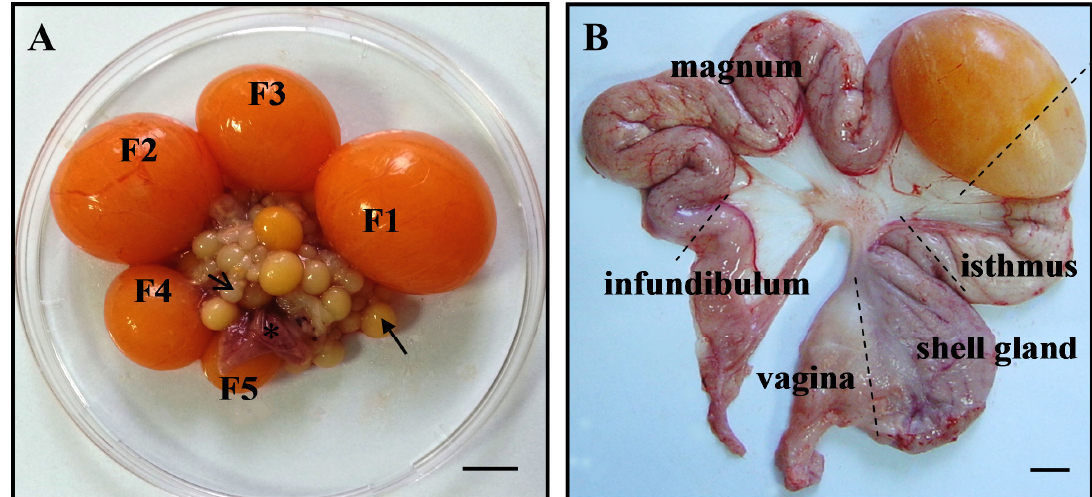
Figure 1. The ovary of an egg ‐ laying hen ( A ). Explanations: white follicle (1–4 mm in diameter; open arrow), yellowish follicle (4–8 mm; arrow), yellow preovulatory follicles (F5–F1; 9–40 mm), postovulatory follicle (asterisk). The oviduct of a laying hen ( B ). Scale bars = 1 cm.